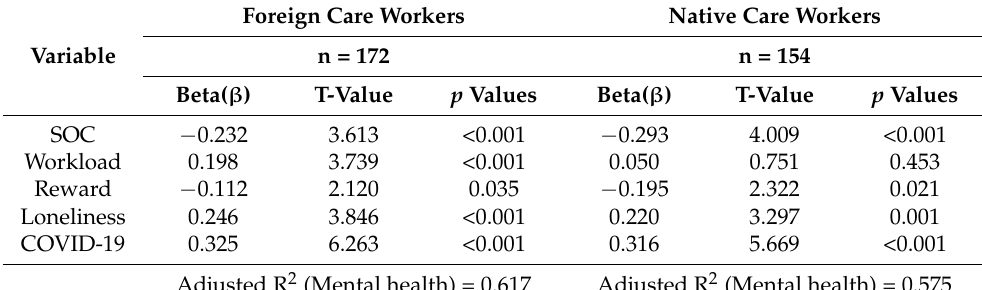
Table 3. Factors associated with mental health among foreign care workers and native care workers.